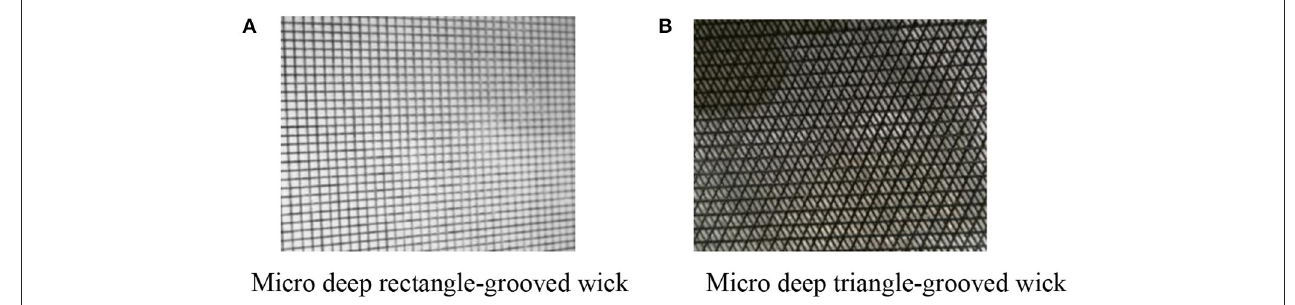
TABLE 4 | The parameters of the sintering wick. Parameter